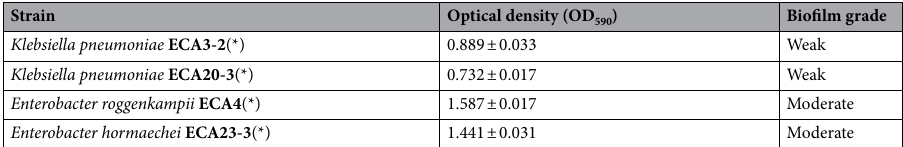
Table 1. Production of biofilm after 24 h of exposure to Arg-SUNCs at 37 °C. The absorbance at 590 nm [optical density (OD) 590 ] was measured, and the strains were grouped into: OD 590 < 0.1, non-producers (NP); OD 590 = 0.1–1.0, weak producers (WP); OD 590 = 1.1–3.0, moderate producers (MP); and OD 590 > 3.0, strong producers (SP). (*) are conventional names of strains.